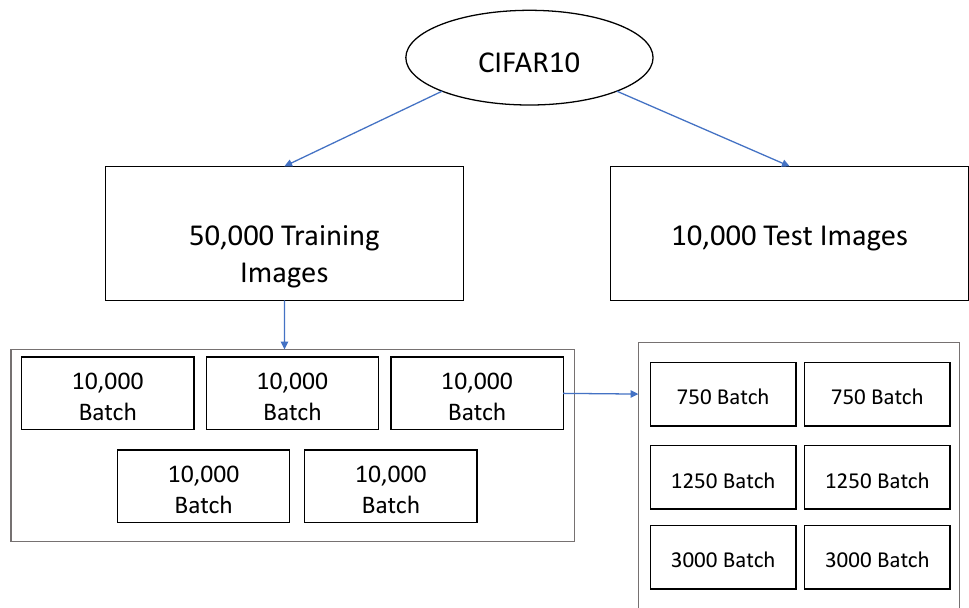
Figure 7. Division of the CIFAR10 dataset for the cross-validation tests.